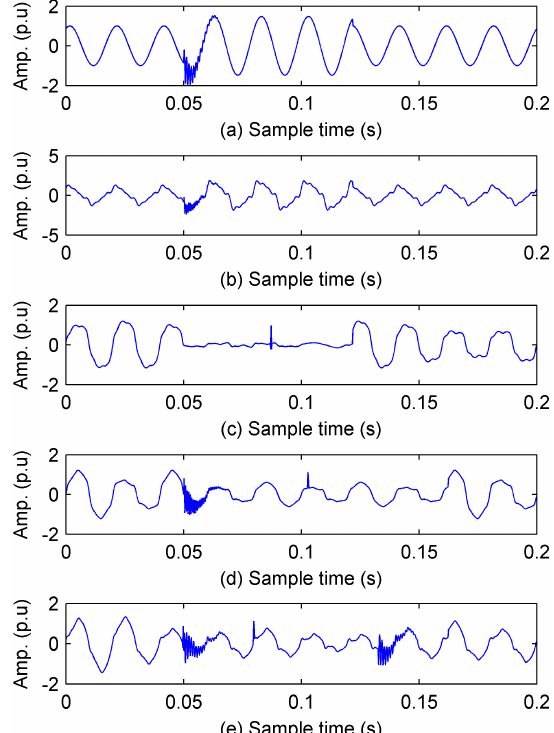
Figure 4. Examples of MPDs; ( a ) swell + oscillation; ( b ) harmonics + swell + oscillation; ( c ) harmonics + interruption + flicker + impulse; ( d ) harmonics + interruption + oscillation + flicker + impulse; ( e ) harmonics + interruption + 2 oscillations + flicker + impulse.